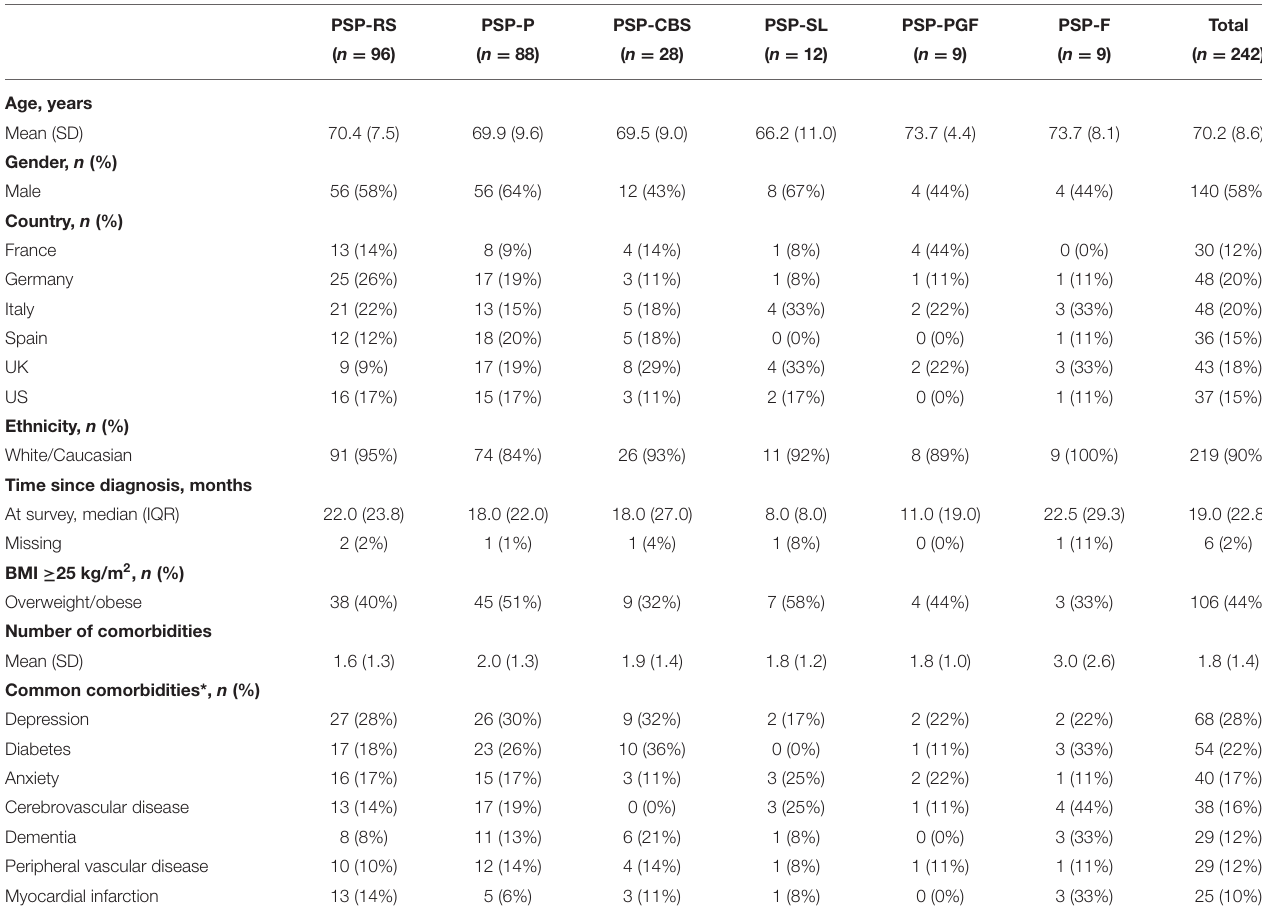
TABLE 1 | Patient demographics and clinical characteristics, by PSP